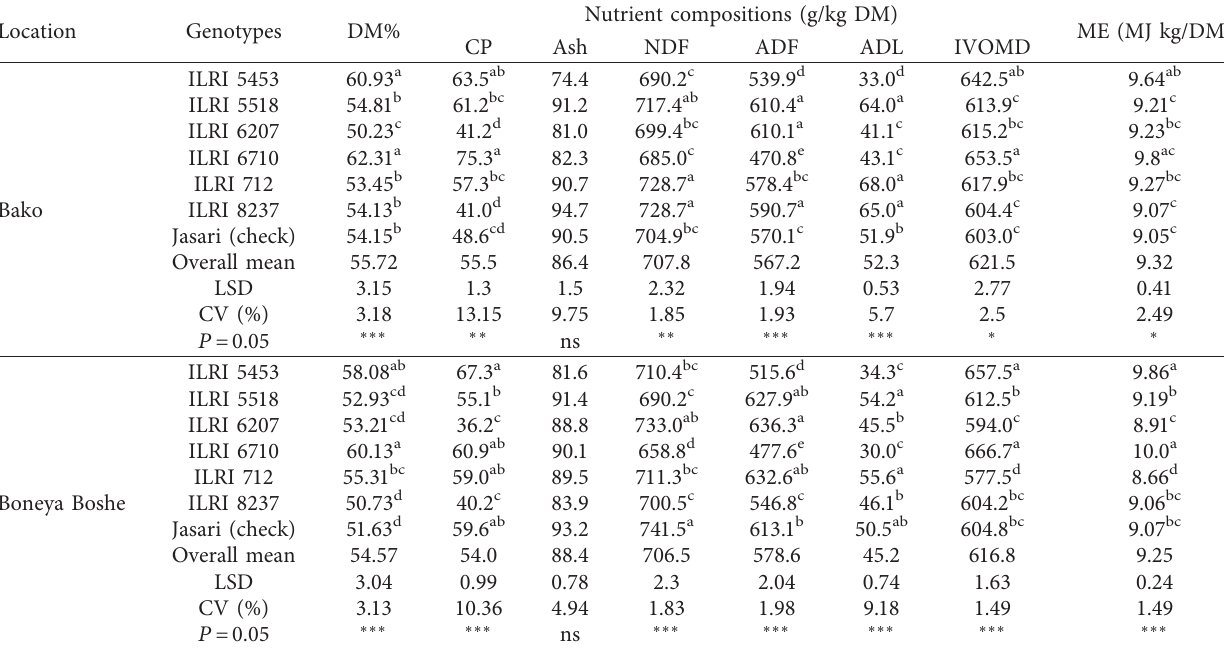
Table 3: Nutrient constituents of the seven oat genotypes at two locations (Bako and Boneya Boshe). Location